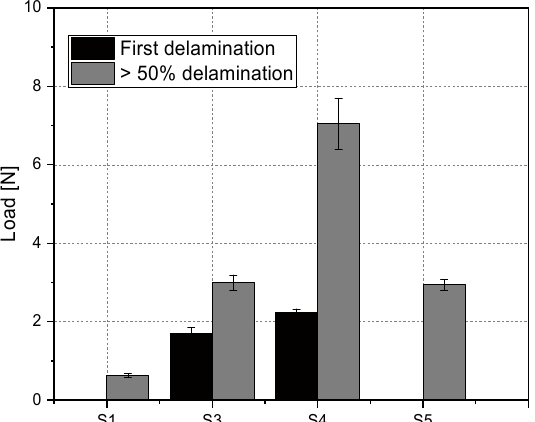
Figure 12. Representative loads for the first delamination and over 50% delamination on undoped oxides and metallic oxides films; S2 and S6 configurations presented heavy premature delamination; and S4 presented the highest load until 50% delamination occurred.